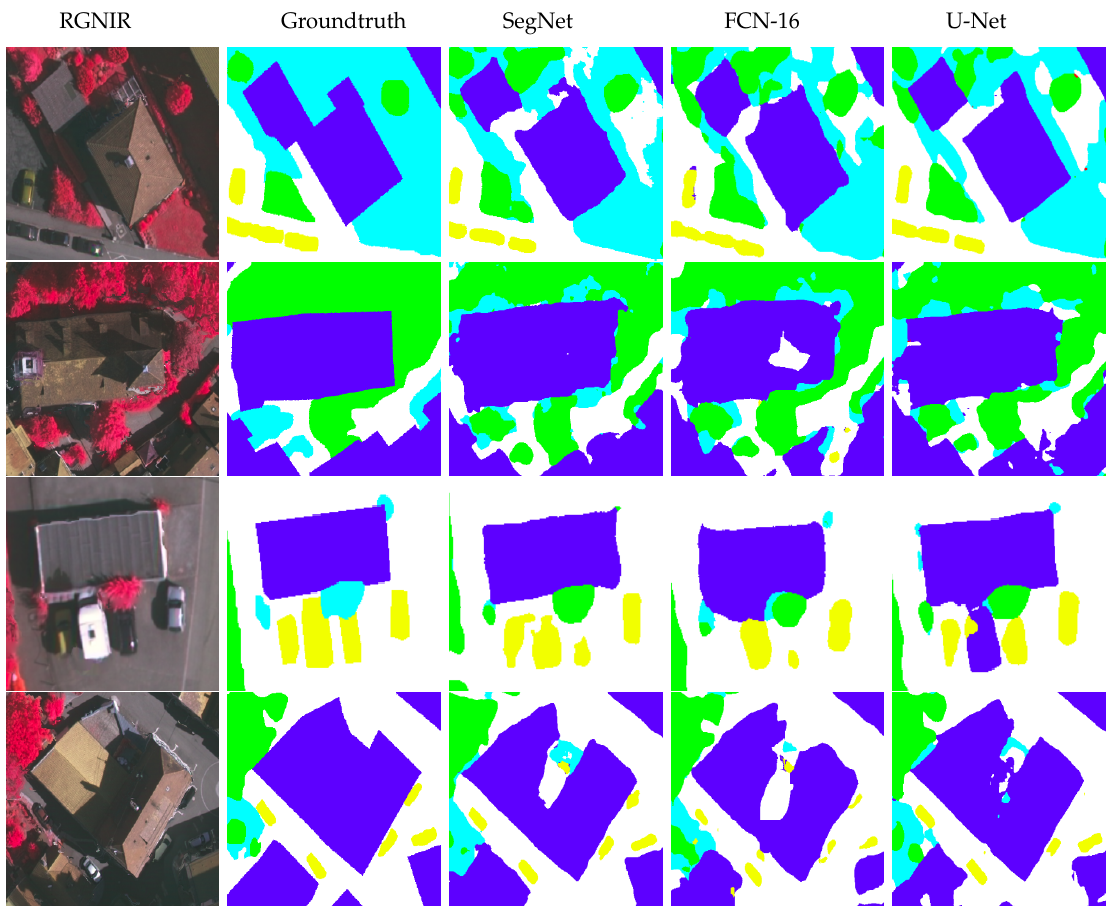
Figure 9. Experimental results from the SegNet, FCN-16 and U-Net fully convolutional networks on indicative regions from the Vaihingen dataset. Along with a false color composite (R-G-NIR), the corresponding ground truth is presented as well (White, Impervious_Surfaces ; Blue, Buildings ; Light Blue, Low_Vegetation ; Green, Trees ; Yellow, Cars ; Red, Clutter